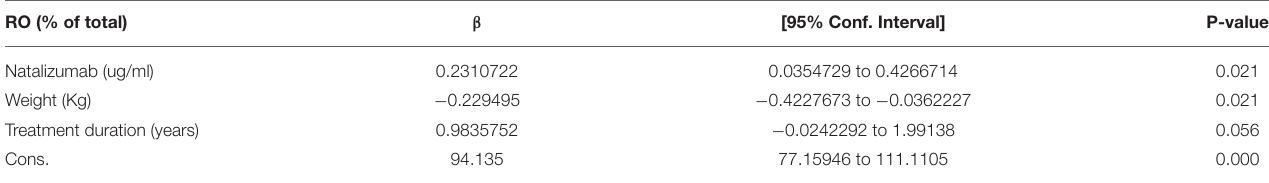
TABLE 6 | Multivariate analysis confirming the relation between natalizumab concentration and receptor occupancy of α 4-integrin. RO (% of total) β [95% Conf. Interval] P-value Natalizumab (ug/ml) 0.2310722 0.0354729 to 0.4266714 0.021 Weight (Kg) − 0.229495 − 0.4227673 to − 0.0362227 0.021 Treatment duration (years)